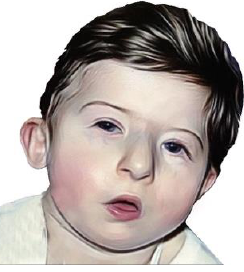
Figure 3. A DSG patient showing characteristic facial appearance, with tubular nose and carp- shaped mouth (redrawn from the original picture free of use under Creative Commons Attribution- Share Alike